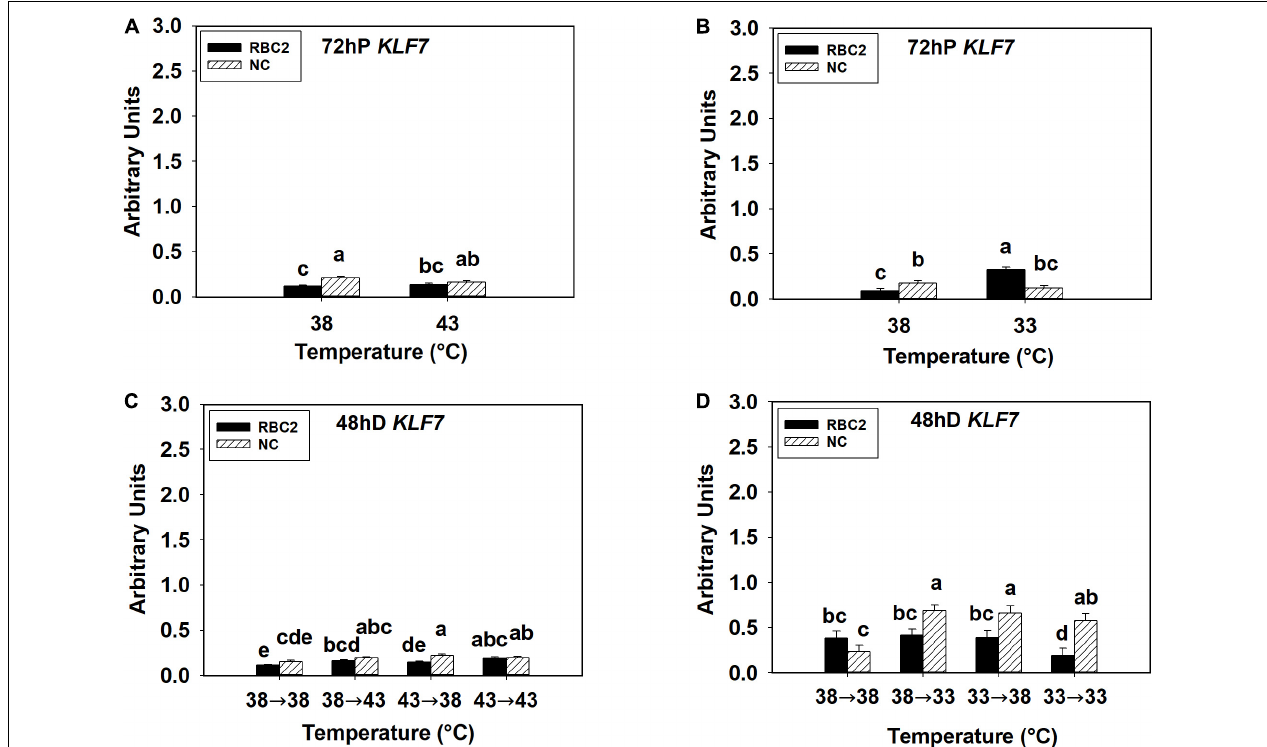
FIGURE 5 | Expression of kruppel like factor 7 ( KLF7 ) at 72 h of proliferation (72 hP) and 48 h of differentiation (48 hD) in satellite cells isolated from the pectoralis major (p. major) muscle of 7-day-old Randombred Control Line 2 (RBC2) and 7-day-old Nicholas Commercial (NC) turkeys. (A) Satellite cell proliferation at 38 ◦ or 43 ◦ C for 72 h. (B) Satellite cell proliferation at 38 ◦ or 33 ◦ C for 72 h. (C) Satellite cell proliferation for 72 h and differentiation for 48 h, both at 38 ◦ C (38 ◦ → 38 ◦ C); proliferation at 38 ◦ C for 72 h and differentiation at 43 ◦ C for 48 h (38 ◦ → 43 ◦ C); proliferation at 43 ◦ C for 72 h and differentiation at 38 ◦ C for 48 h (43 ◦ → 38 ◦ C); or proliferation for 72 h and differentiation for 48 h, both at 43 ◦ C (43 ◦ → 43 ◦ C). (D) Satellite cell proliferation for 72 h and differentiation for 48 h, both at 38 ◦ C (38 ◦ → 38 ◦ C); proliferation at 38 ◦ C for 72 h and differentiation at 33 ◦ C for 48 h (38 ◦ → 33 ◦ C); proliferation at 33 ◦ C for 72 h and differentiation at 38 ◦ C for 48 h (33 ◦ → 38 ◦ C); or proliferation for 72 h and differentiation for 48 h, both at 33 ◦ C (33 ◦ → 33 ◦ C). Each graph bar represents a mean arbitrary unit, and each error bar represents a standard error of the mean. Mean values without a same letter were significantly different ( P ≤